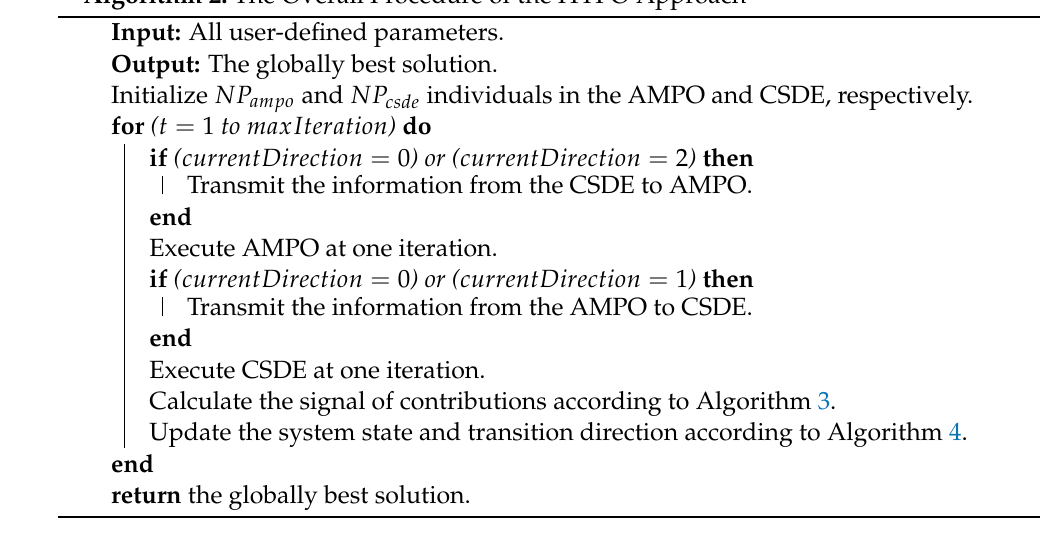
Algorithm 2: The Overall Procedure of the HYPO